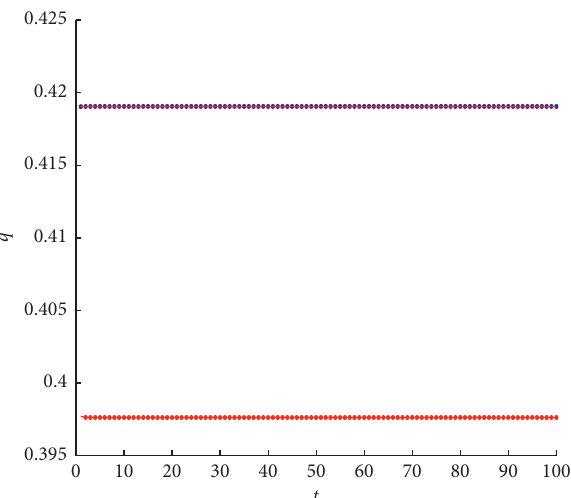
Figure 8: Time series of q